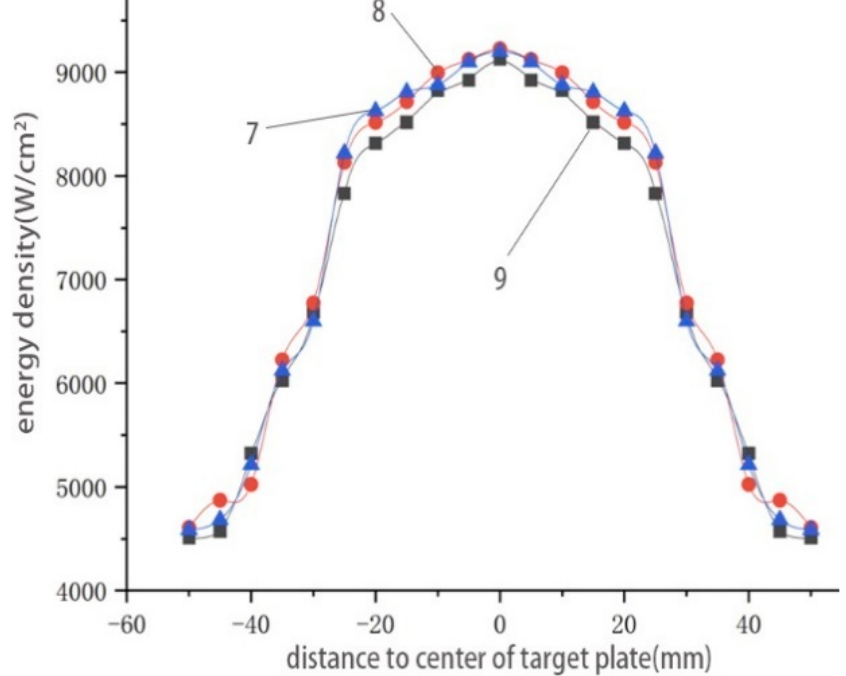
Figure 16. Energy density distribution on the steel target.